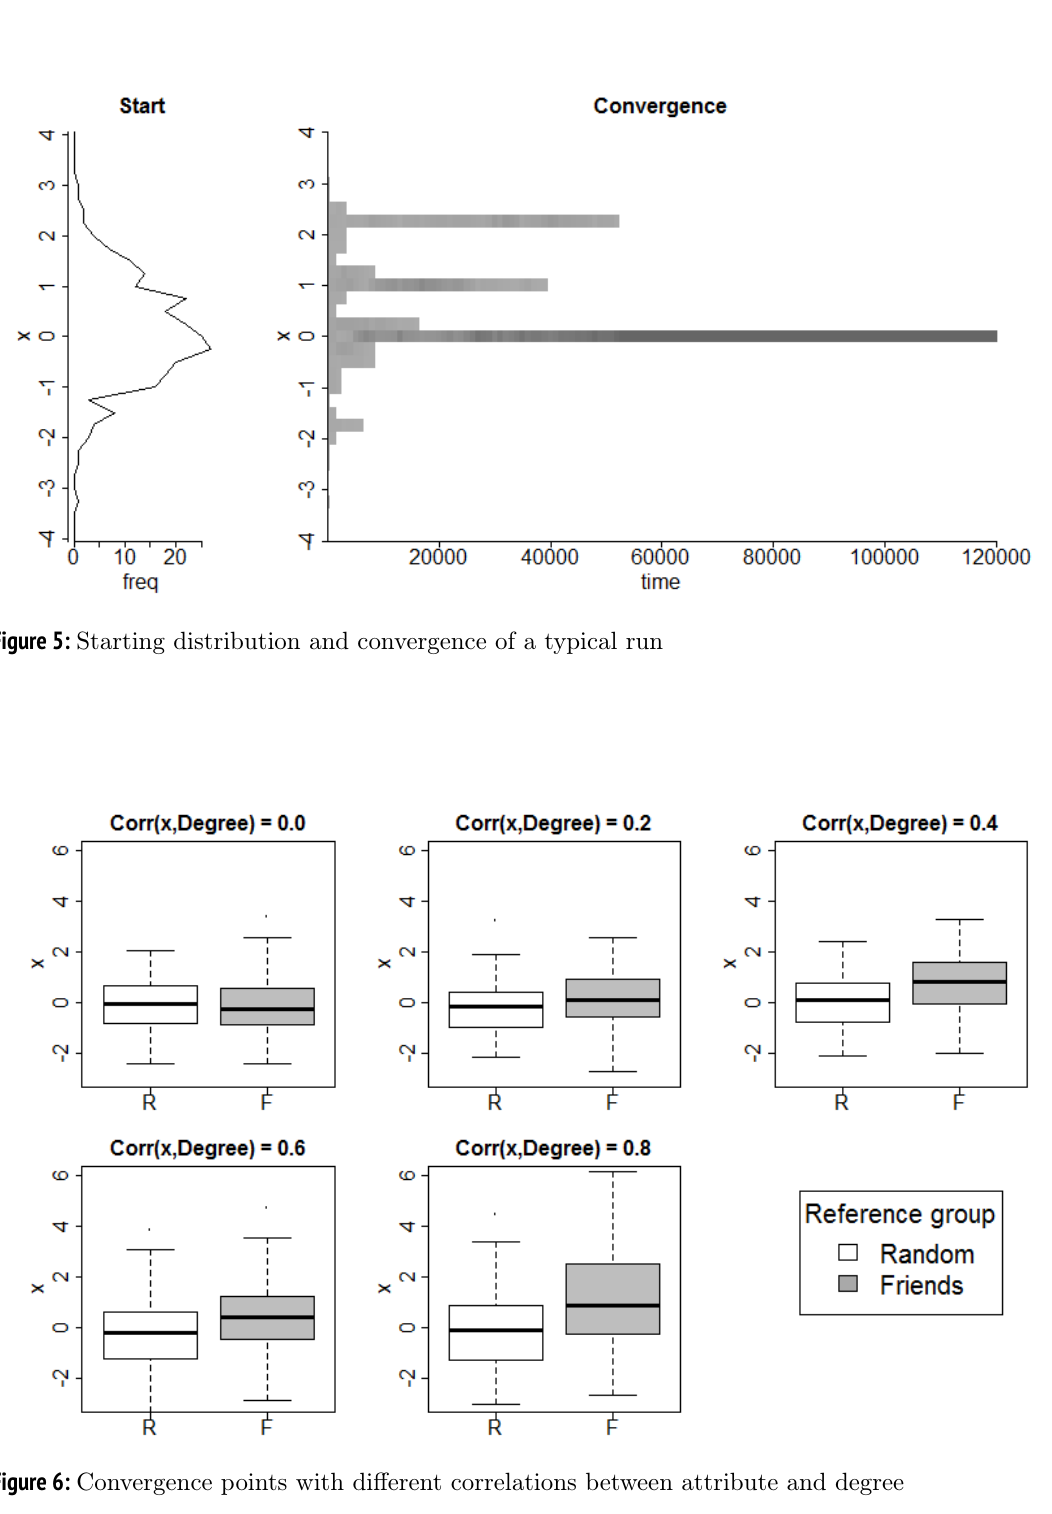
sociological science |